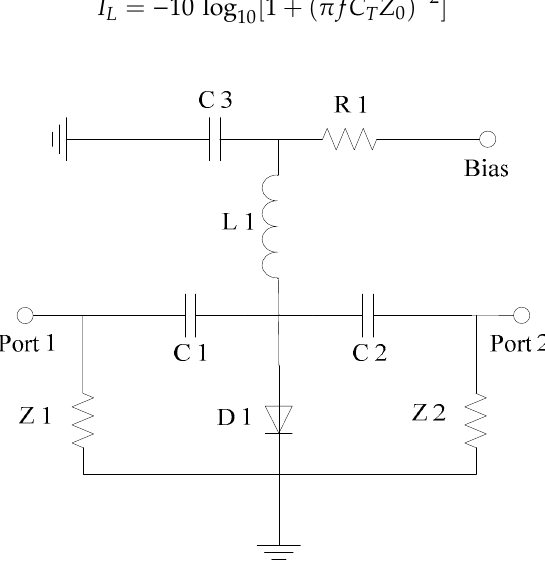
Figure 7. Circuit schematic of the shunt PIN switch.